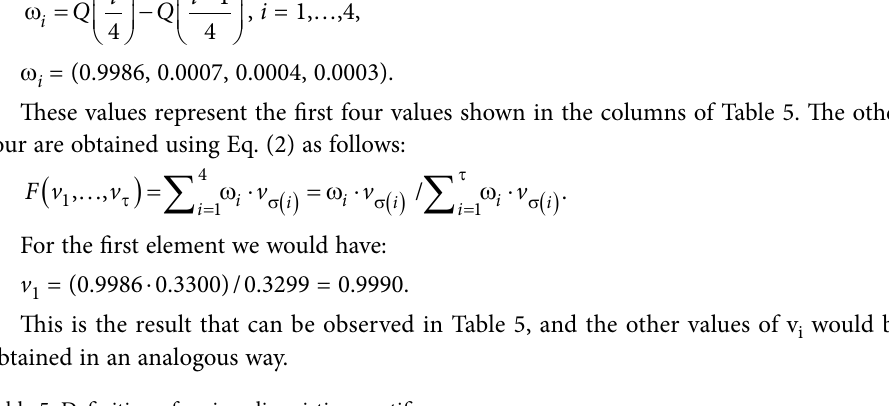
Table 5. Definition of various linguistic